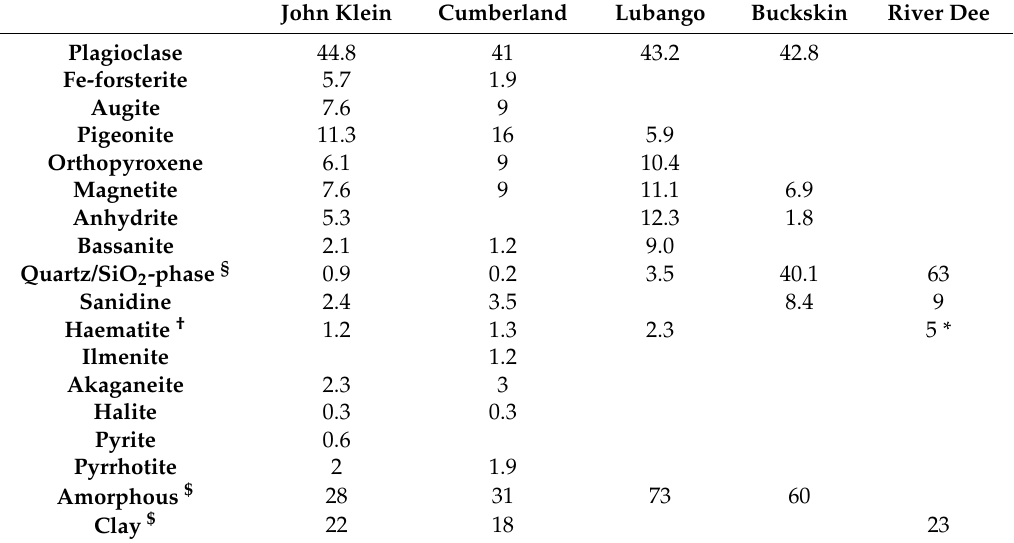
Table 3. A mineralogical comparison between anaerobic zone of the River Dee sampling site and four selected samples analysed at Gale crater as measured in the John Klein, Cumberland, Lubango, and Buckskin drill holes. Data for John Klein and Cumberland from [18], Lubango from [24], Buckskin from [27], River Dee this study. Unit: wt. %. * indicates that the value is a combination of abundances for all minor fractions. † denotes that for the River Dee sample, titanohaematite is the main mineral. § The value is for quartz in all samples except Buckskin, where the SiO 2 -phase comprises of 6.0% cristobalite, 34.1% tridymite; the amorphous material includes 6.0 wt. % Opal-CT. $ Note that the crystalline phase is normalized to 100%, the amount of amorphous material and clay is given separately at the end of the table. John Klein Cumberland Lubango Buckskin River